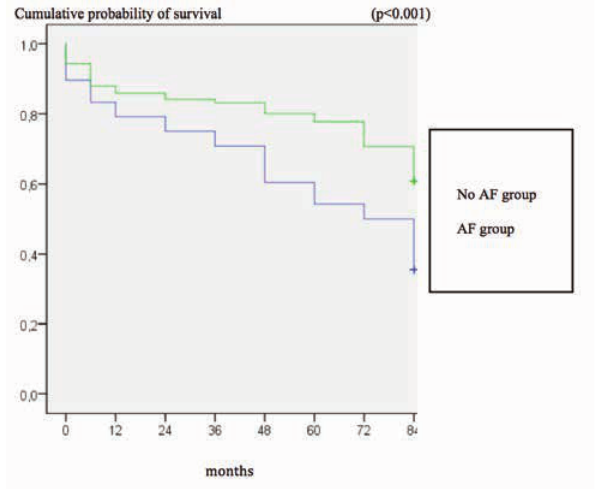
Figure 1: Crude cumulative incidence of mortality during the follows up period of 48 months presented by Kaplan-Meier plots. Green line –No AF group. Blue line – AF